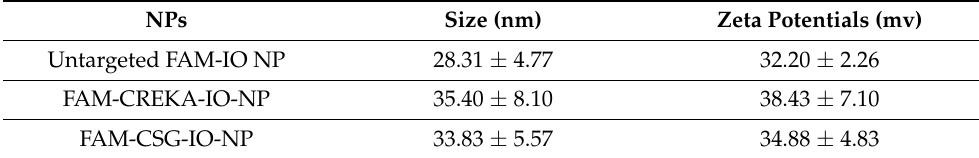
Table 2. IO-NP sizes and their zeta potentials as measured by dynamic light scattering (DLS).